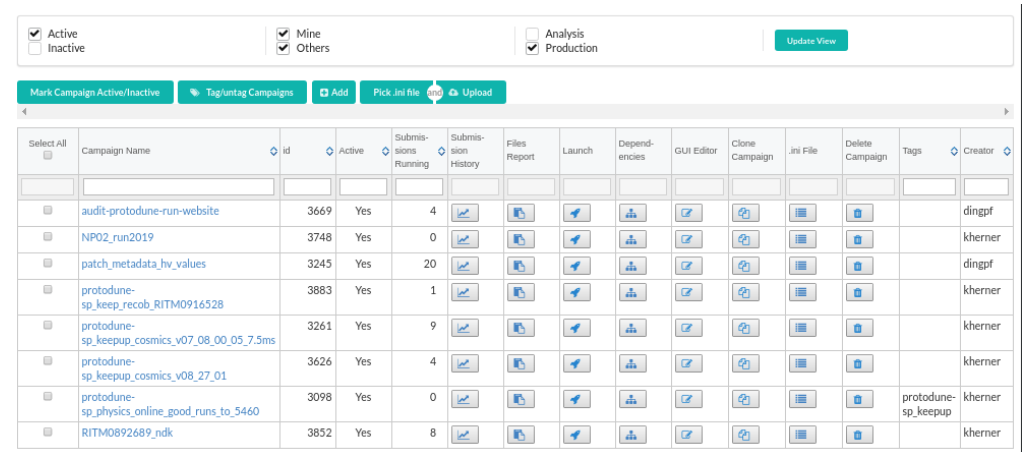
Figure 2. POMS campaign management